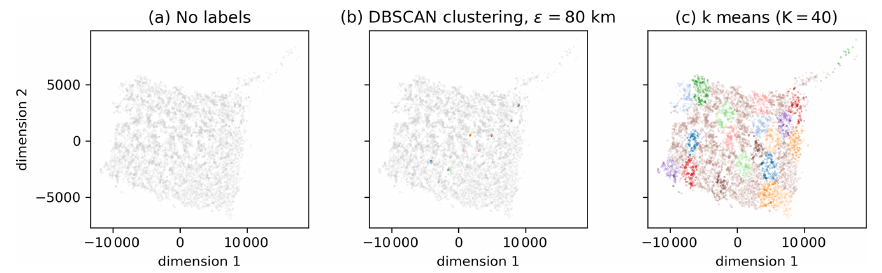
Figure 8. Embedding of the Agulhas trajectories in the 2D space defined by the leading eigenvectors of the MDS kernel matrix B . (a) No labels. (b) Clustering labels of OPTICS and DBSCAN (see Fig. 9 for the corresponding plot in the Agulhas region). Grey particles represent noise. (c) The k -means with K = 40 (see Fig. 10 for the corresponding plot in the Agulhas domain.)